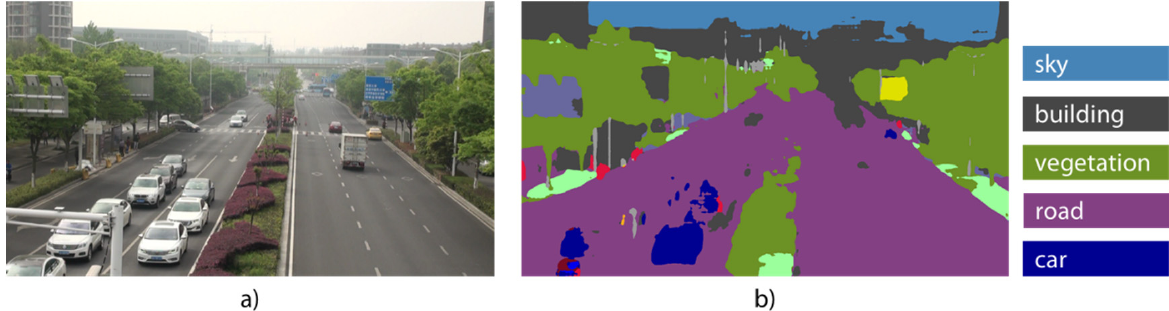
Figure 5. Example of image segmentation based on road video data. ( a ) Road video example and ( b ) the image semantic separation result.